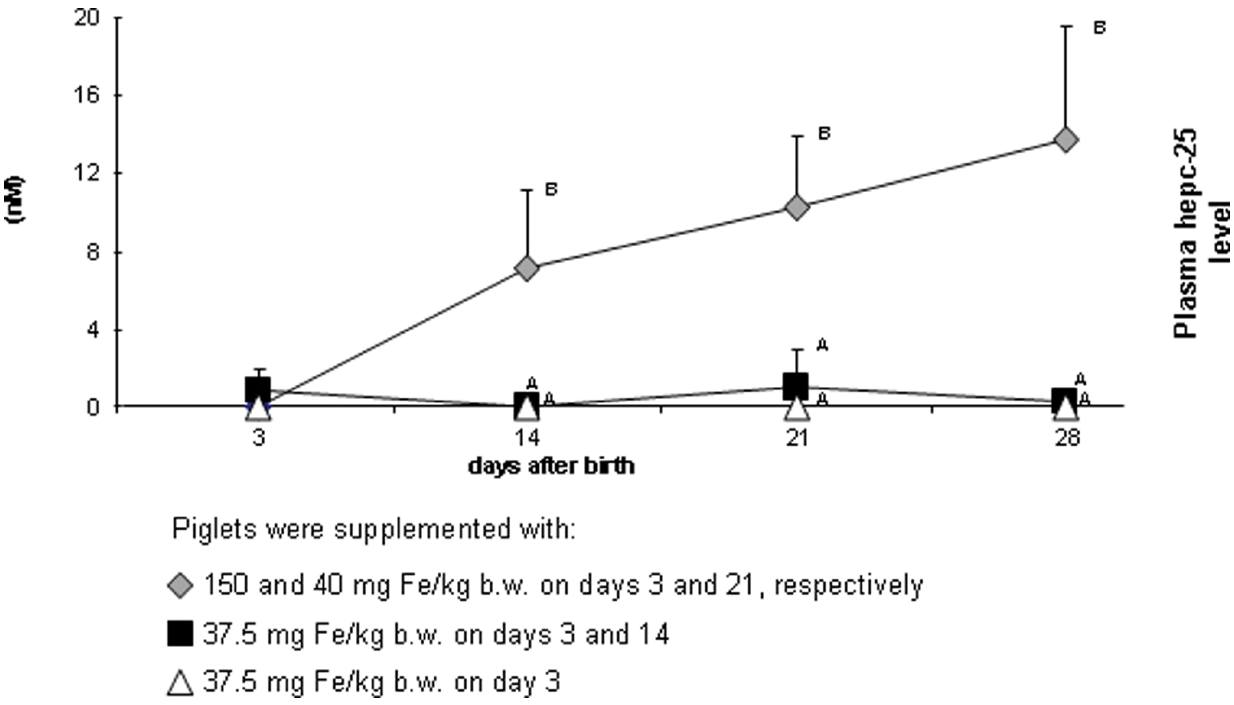
Figure 4. Hepcidin concentration in blood plasma of piglets supplemented with iron dextran according to various protocols. Values are expressed as the means 6 S.D. Hepcidin concentration was determined for 5–7 piglets from each group/day. Different capital and small letters denotes statistically significant difference at P # 0.01 and P # 0.05, respectively, between parameters of piglets from different groups on a given day of experiment.